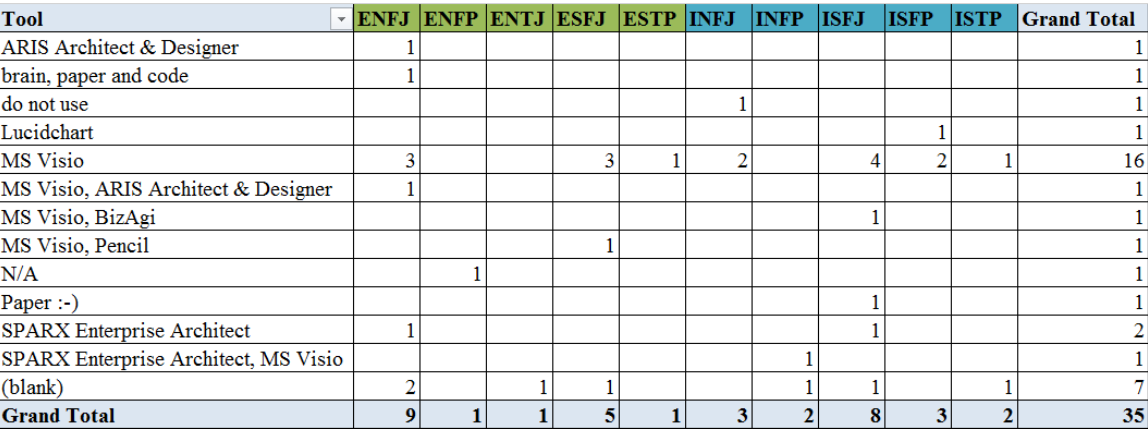
Table 7. Distribution by preferred modelling